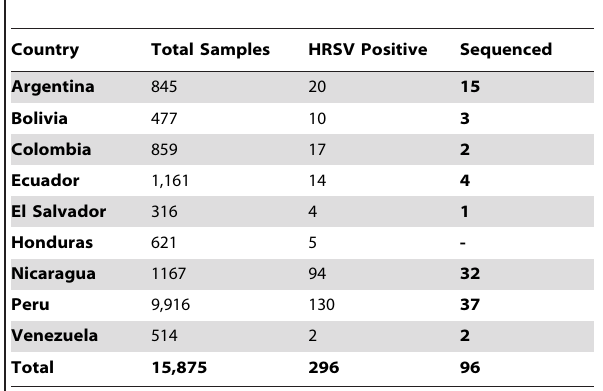
Table 1. Number of Samples by Country.